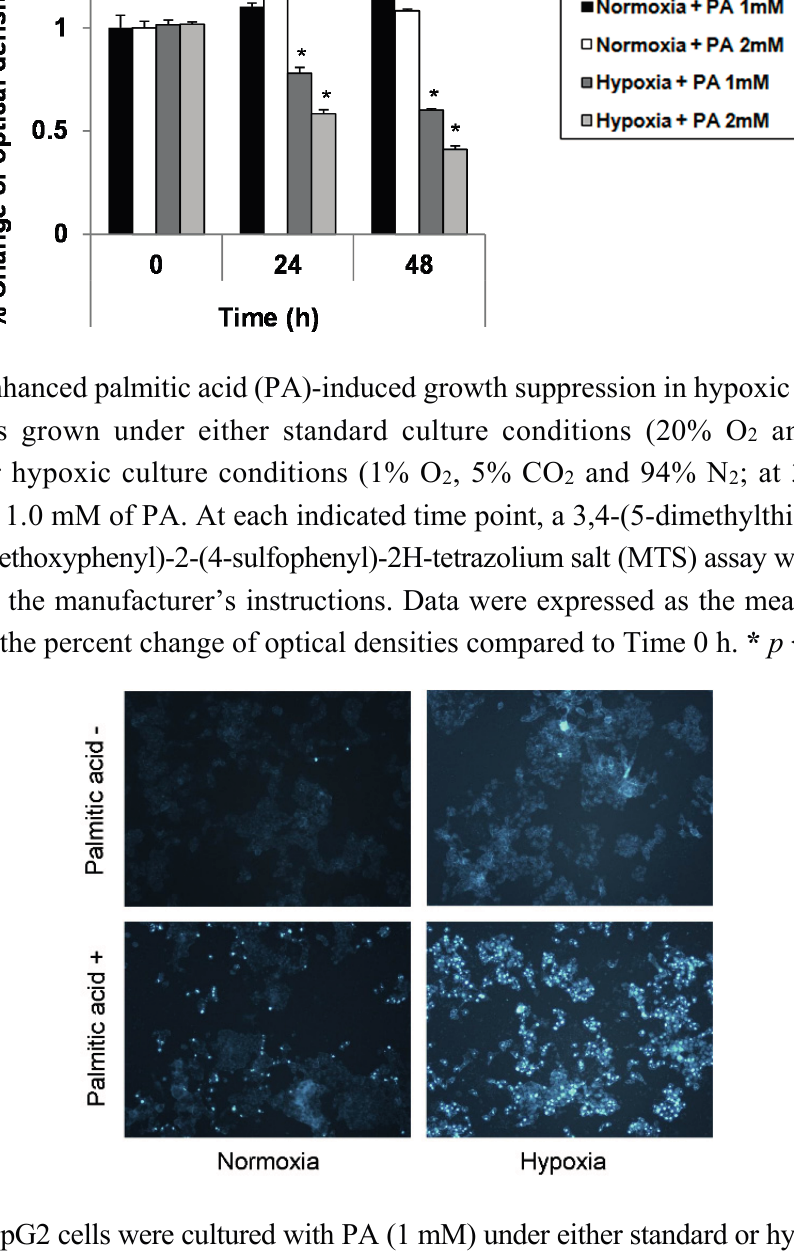
Figure 2. HepG2 cells were cultured with PA (1 mM) under either standard or hypoxic culture conditions for 24 h. Apoptosis was assessed by 4',6-diamidino-2-phenylindole dihydrochloride (DAPI) staining. Original magnification,